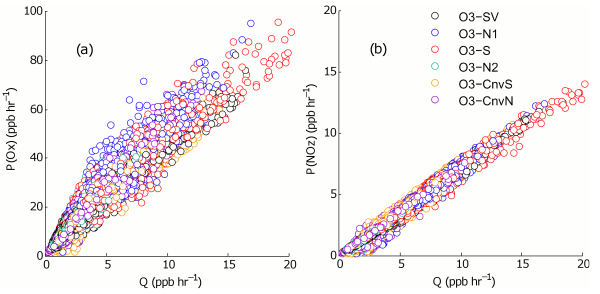
Fig. 9. Indicators examining the VOC- or NO x -limited conditions for urban area during 12:00–17:00LT; Relationships between pri- mary radical production rates and (a) O x formation rate and (b) NO x oxidation